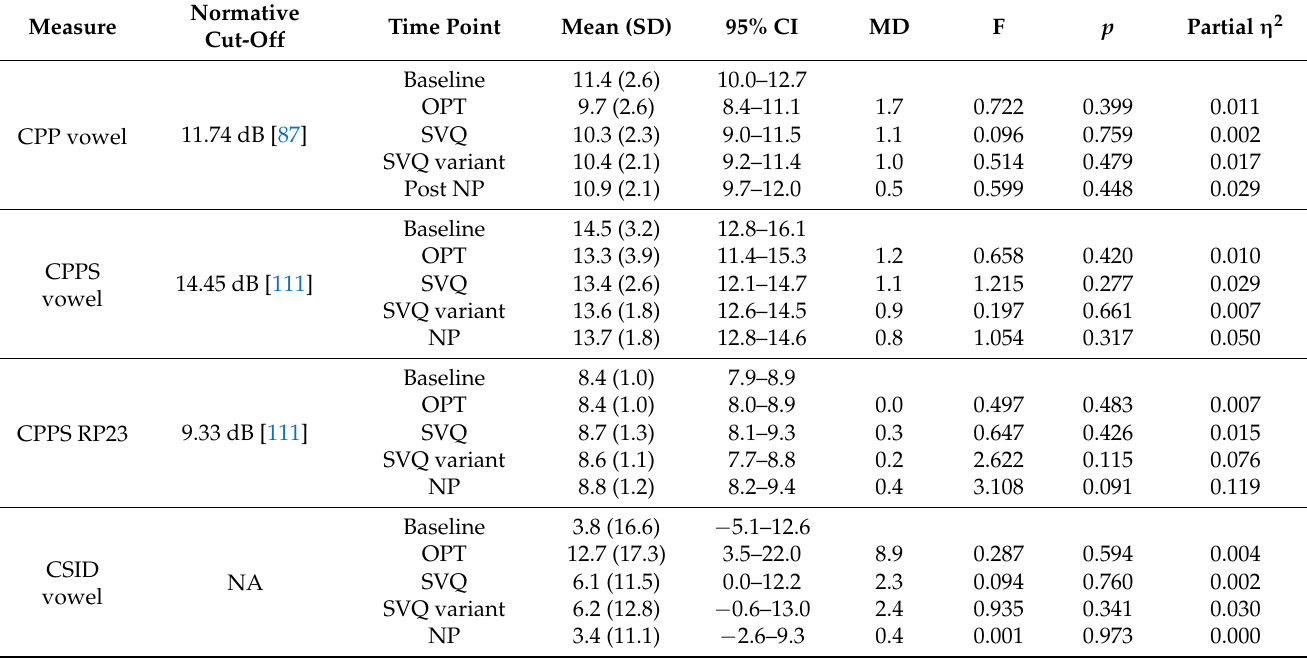
Table A4. Changes in the acoustic outcomes before and after the four stages of Sob Voice Therapy. Partial η 2 = 0.01, 0.1, and 0.25 indicate small, medium, and large effects,